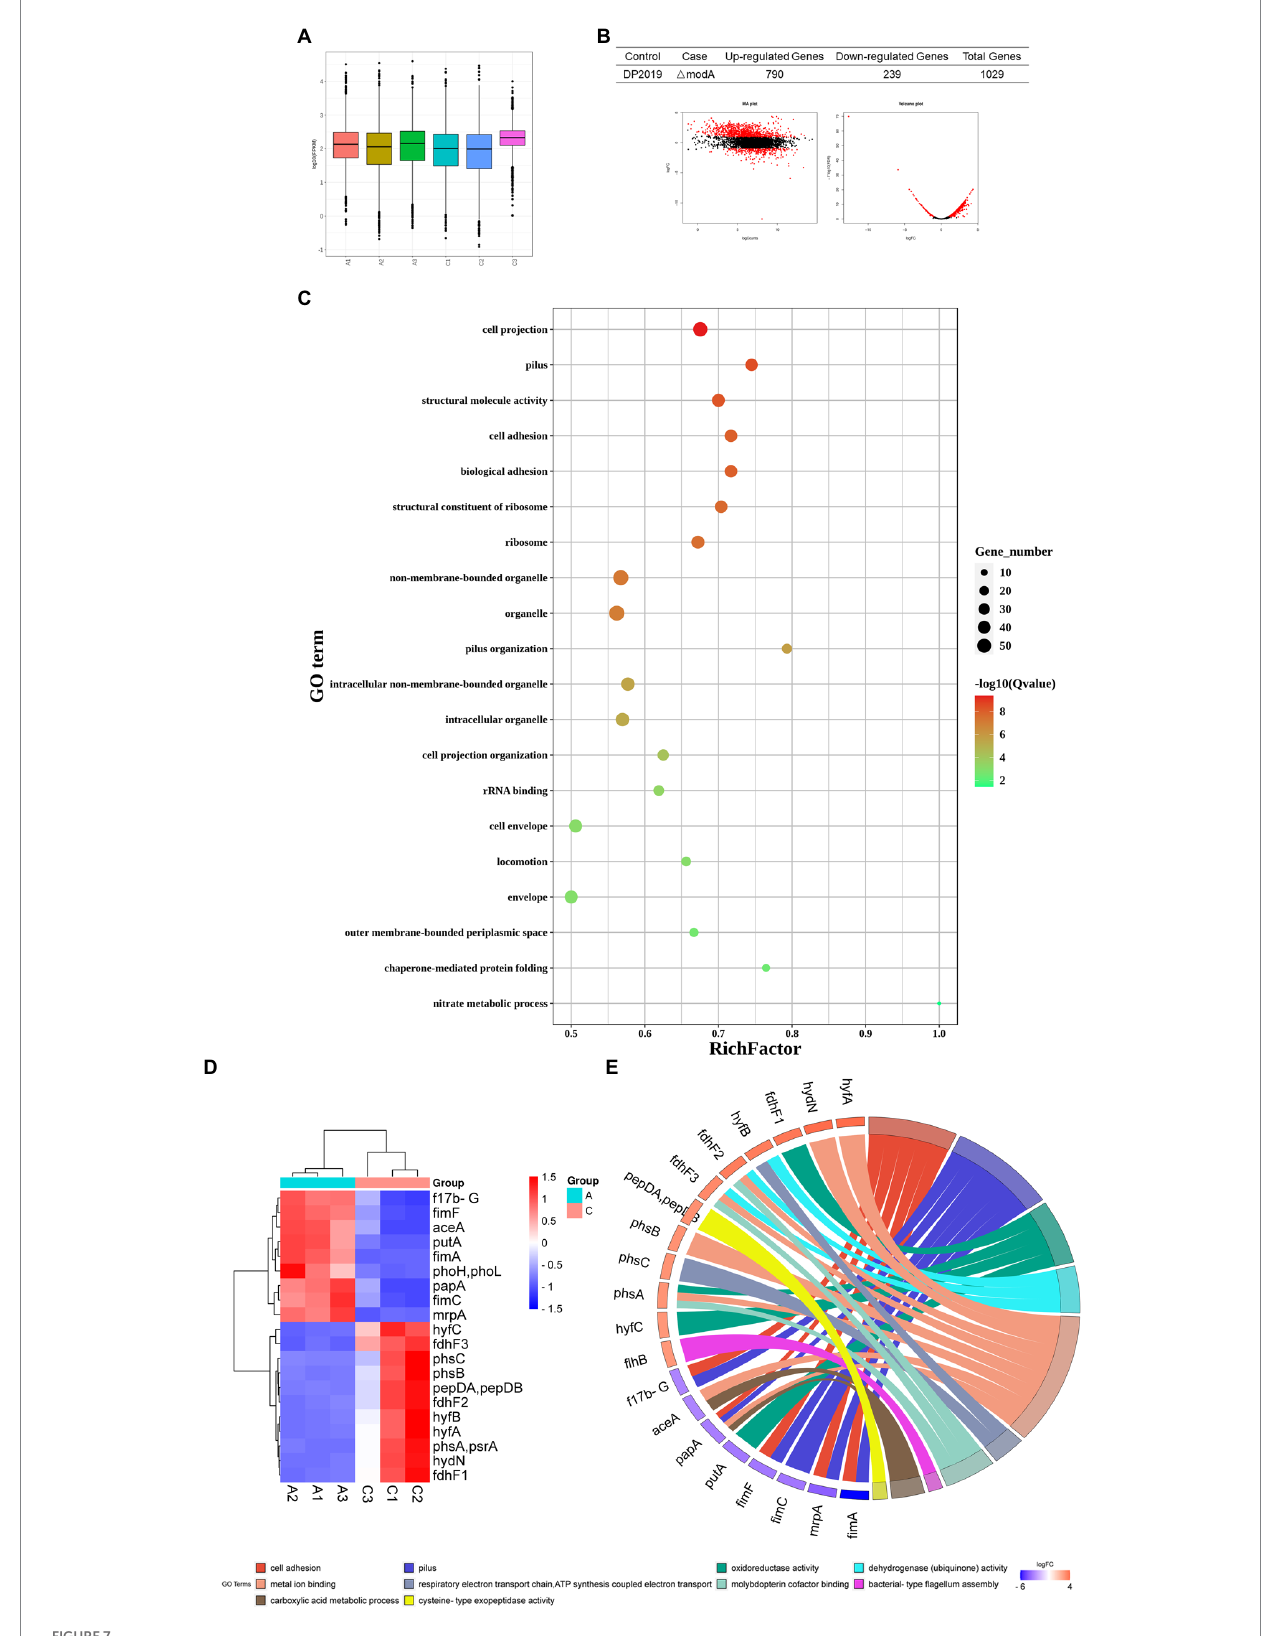
FIGURE 7 Functional analysis of DEGs. “A” represents the control group DP2019 and “C” represents the Δ modA group. (A) FPKM box graph of different samples of DP2019 and Δ modA . The abscissa shows the sample name, the ordinate shows log 10 (FPKM). The box graph of each area corresponds to five statistics